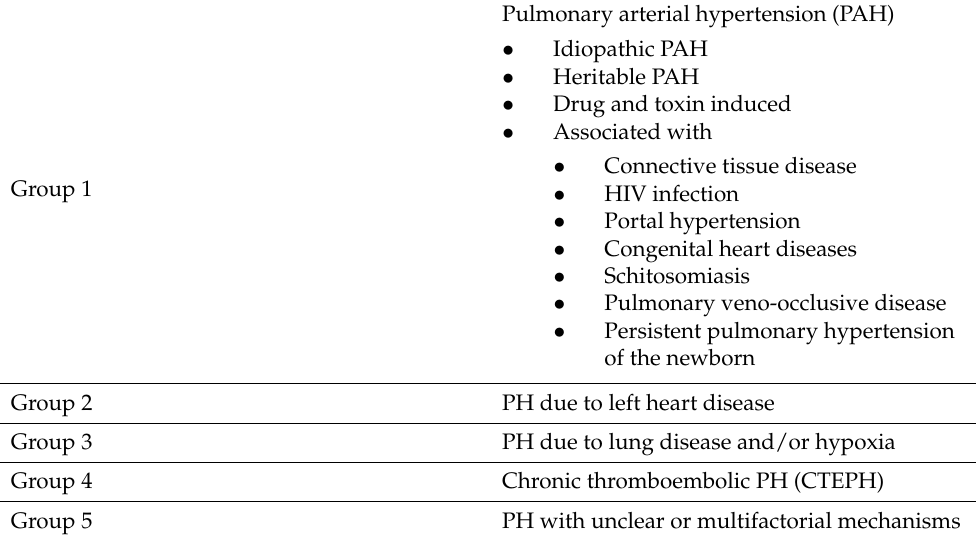
Table 1. Classification of pulmonary hypertension